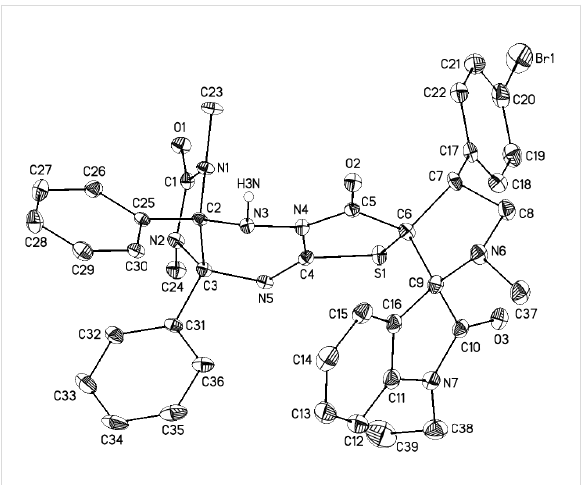
Figure 5: General view of 4c in the crystal in thermal ellipsoids repre- sentation (50% probability). Hydrogen atoms connected to carbon atoms are omitted for clarity.